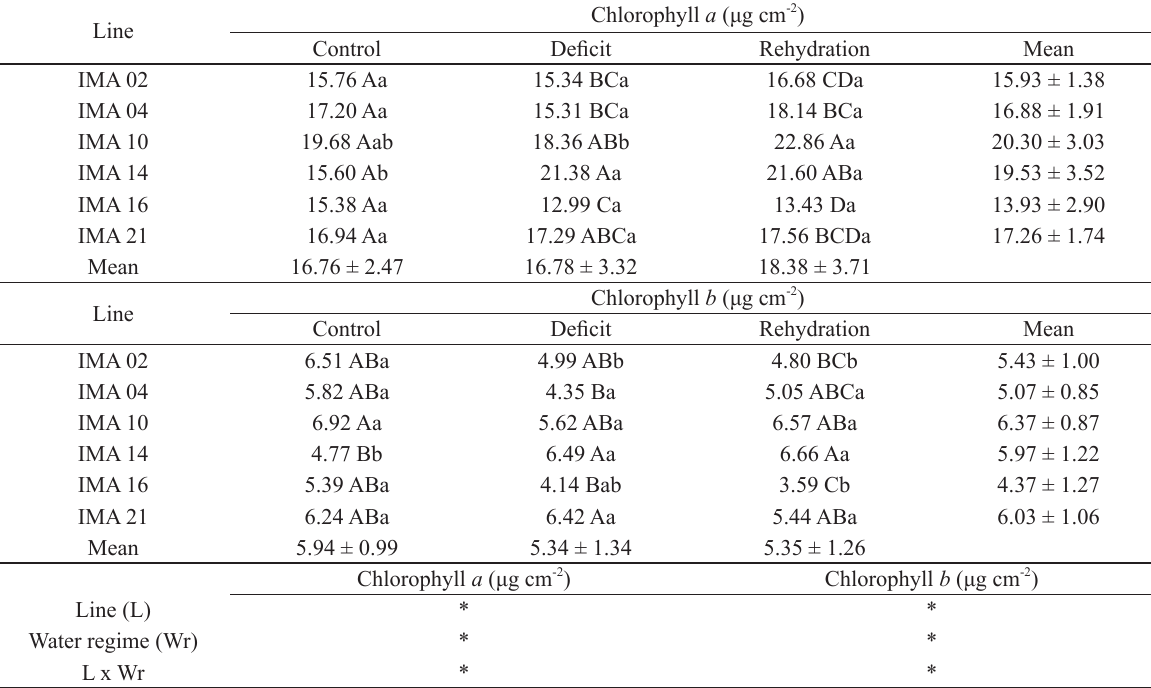
Effect of water deficit and rehydration on the content of chlorophyll a and chlorophyll b in six safflower lines in Botucatu – São Paulo,